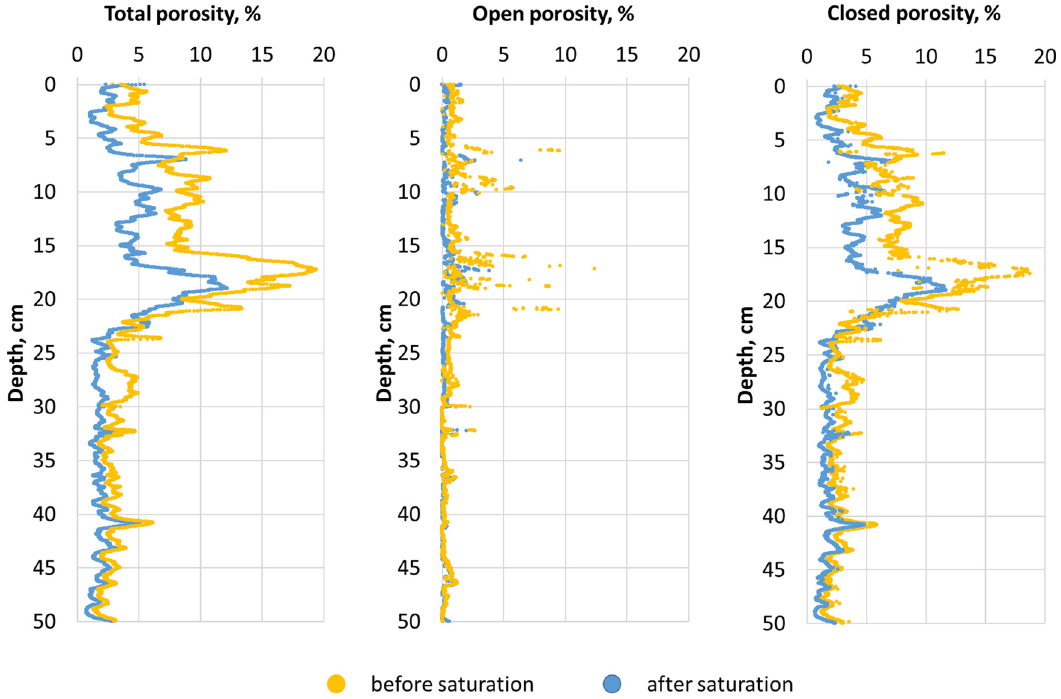
Figure 4: Calculated soil porosity according to 2D